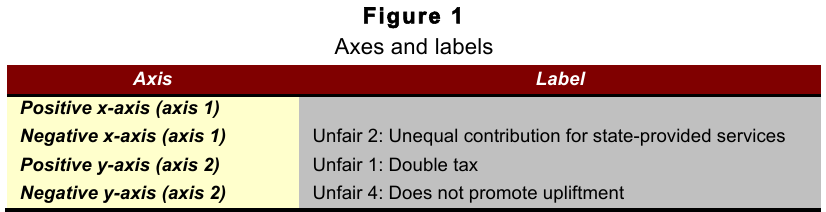
coefficients with the chosen axis. Unfairness criteria 3 had both a very low level of inertia and weak correlation with two